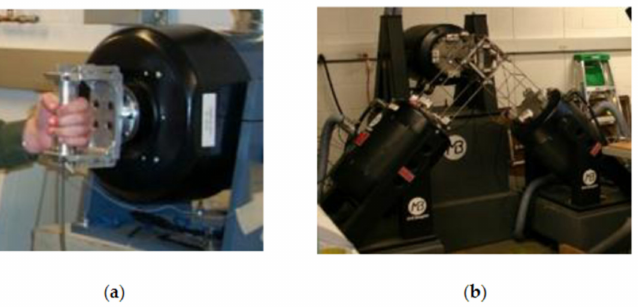
Figure 4. The hand–arm vibration test systems in NIOSH: ( a ) 1D system; and ( b ) 3D system